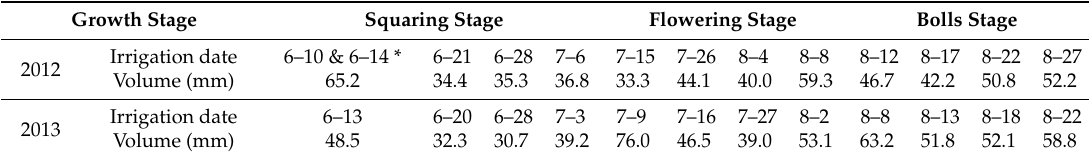
Table 1. Irrigation schedules adopted for experiments in 2012 and 2013.